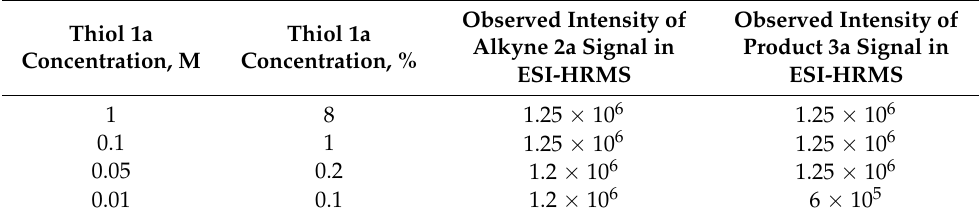
Table 1. Dependence of signal intensity in the ESI-MS spectrum on the concentration of substrates in petroleum. Observed Intensity of Observed Intensity of Thiol 1a Thiol 1a Product 3a Signal in Alkyne 2a Signal in Concentration, M Concentration, % ESI-HRMS ESI-HRMS 1 8 1.25 × 10 6 1.25 × 10 6 0.1 1 1.25 × 10 6 1.25 × 10 6 0.05 0.2 1.2 × 10 6 1.25 × 10 6 0.01 0.1 1.2 × 10 6 6 × 10